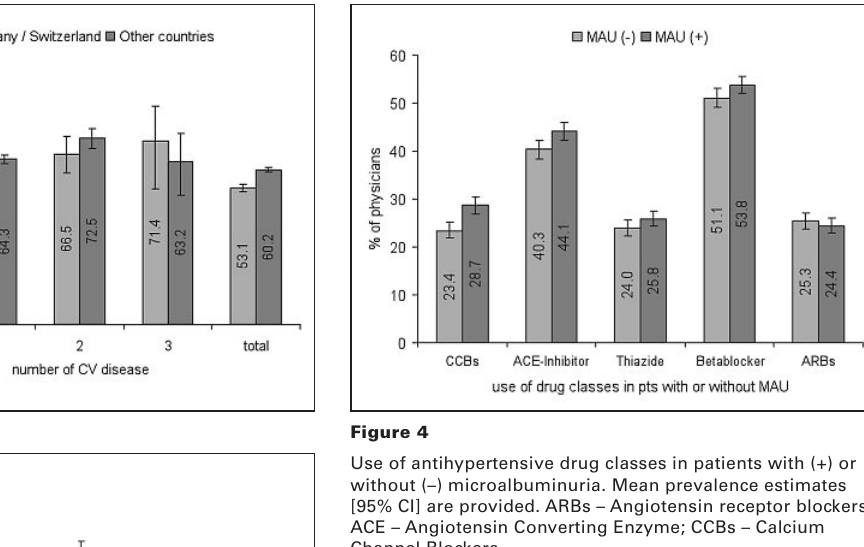
Mean prevalence estimates [95% CI] of MAU in patients receiving specific antihypertensive drug classes; ARBs – Angiotensin receptor blockers; ACE – Angiotensin Convert- ing Enzyme; CCBs – Calcium Channel